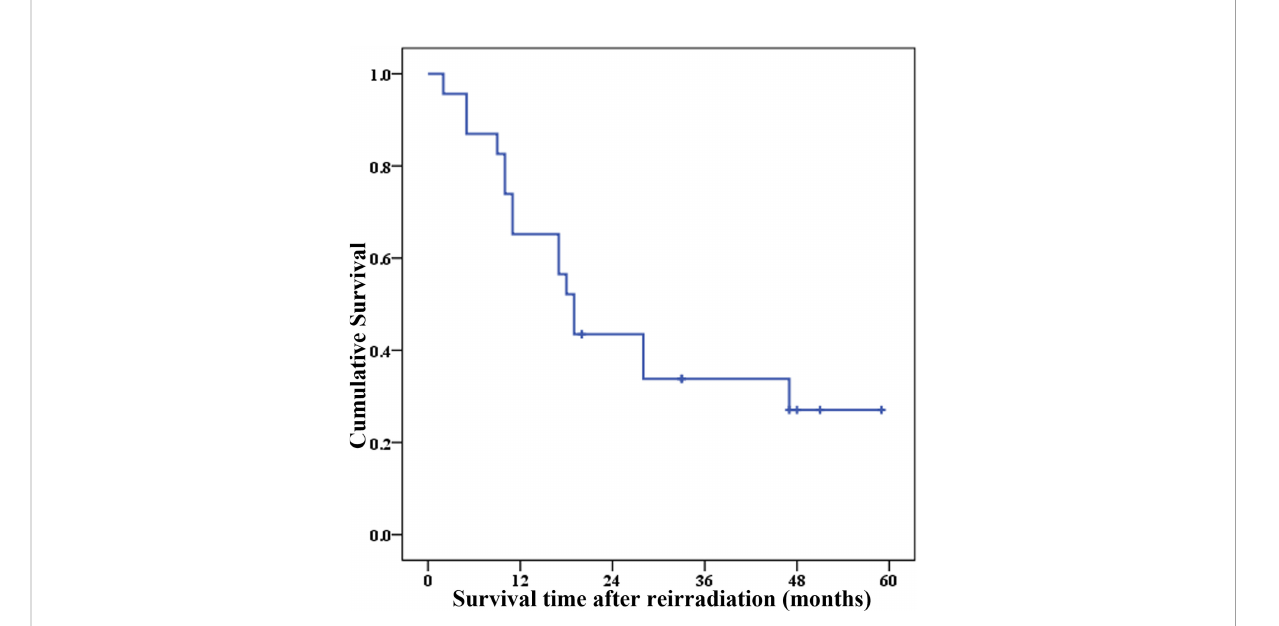
FIGURE 3 Survival curve of PRS after reirradiation in 23 patients with recurrent cervical